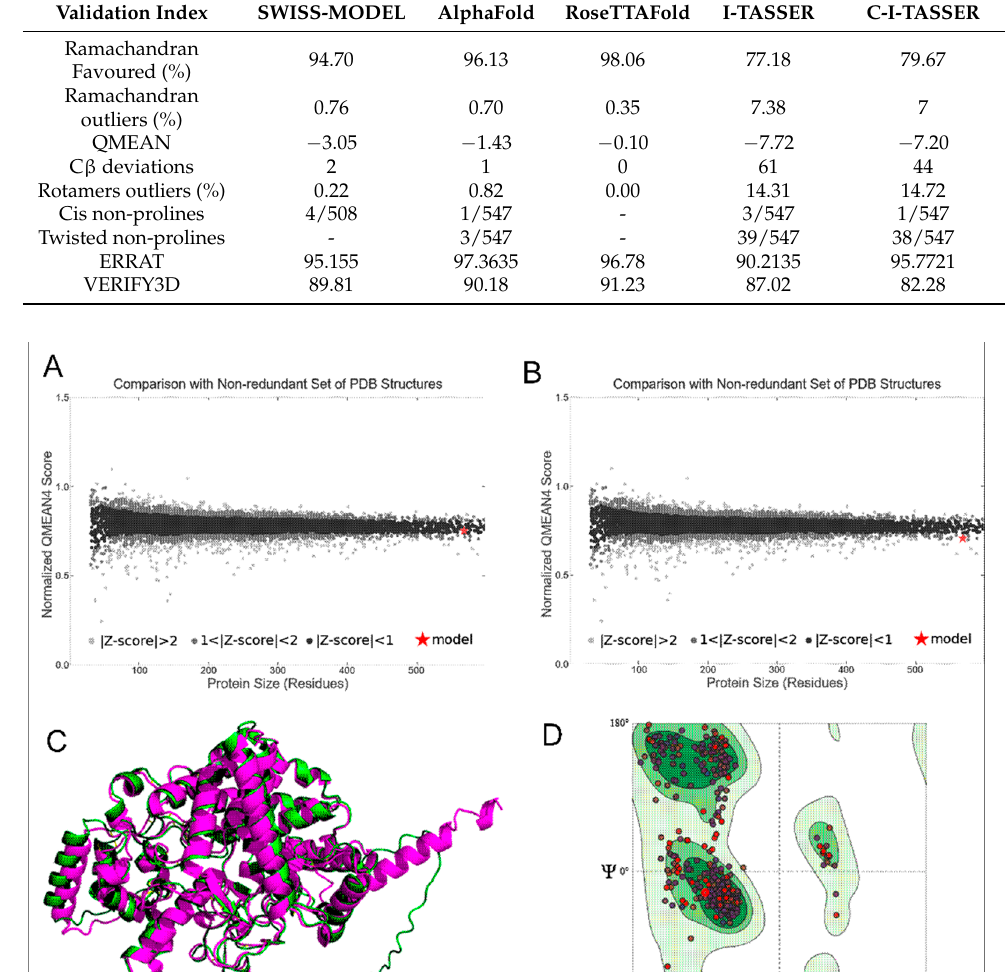
Table 1. Structural assessment of predicted 3D structures of Anopheles gambiae trehalase ( Ag Tre).